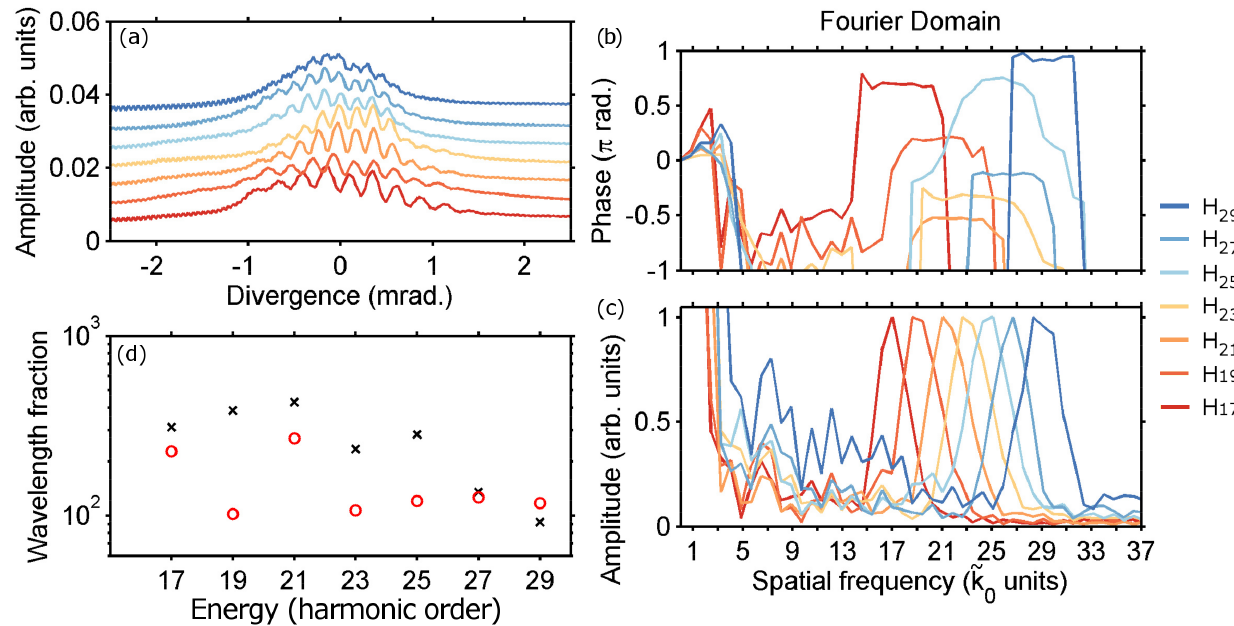
Figure 6. (Color on-line) ( a ) The fringes’ lineout of H (red) to H (blue) generated 17 29 in nitrogen with the LUCA laser. Each harmonic order was integrated over a 0.2-photon unit interval centered at the harmonic frequency; the harmonic spatial profiles have been arbitrarily shifted for clarity; ( b ) phase and ( c ) amplitude of the Fourier transform of each fringe pattern presented in (a); the phase has been wrapped, so that its variations around the amplitude peak are clearly visible for each harmonic order. The amplitude has been normalized at the non-zero spatial frequency peak. ( d ) The red circles represent the precision of the interferometer evaluated as 2 π times the inverse of the standard deviation of the phase over the spatial frequency width of each amplitude peak. The black “x”-shaped crosses indicate the long-term stability of the interferometer estimated as 2 π times the inverse of the standard deviation of the phase for about ten thousand